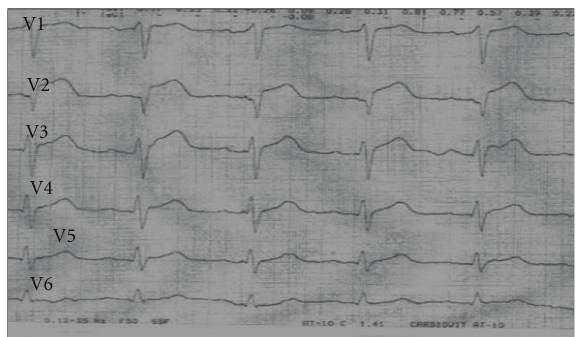
Figure 1: Chest leads electrocardiogram showing ST-segment elevations in V2, V3, and